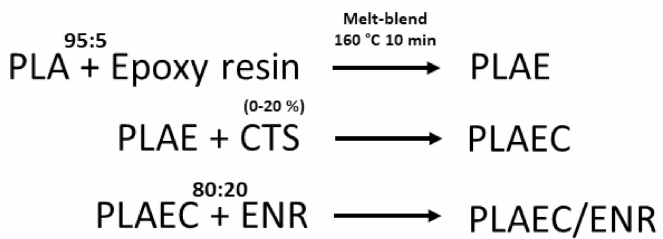
Figure 2. Schematic of sample preparation.